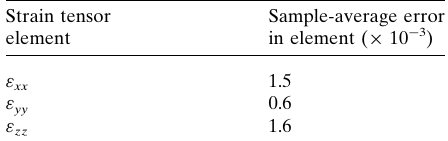
Table 2 Sample-average errors in grain strain tensor diagonal elements as output by FitAllB